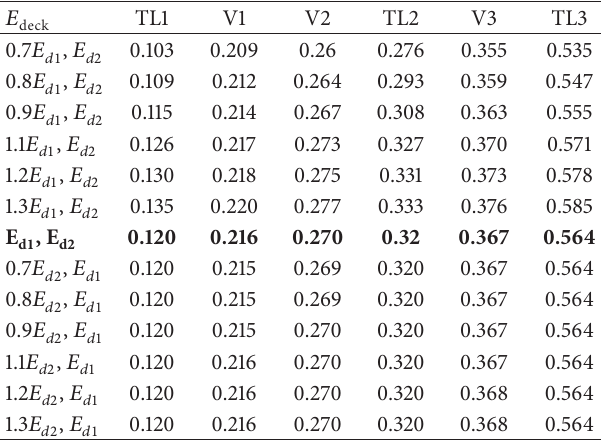
Table 3: Comparison of natural frequencies (Hz) with changes in Young’s modulus of steel girders ( 𝐸 𝑑1 ) and PC girders ( 𝐸 𝑑2 ).